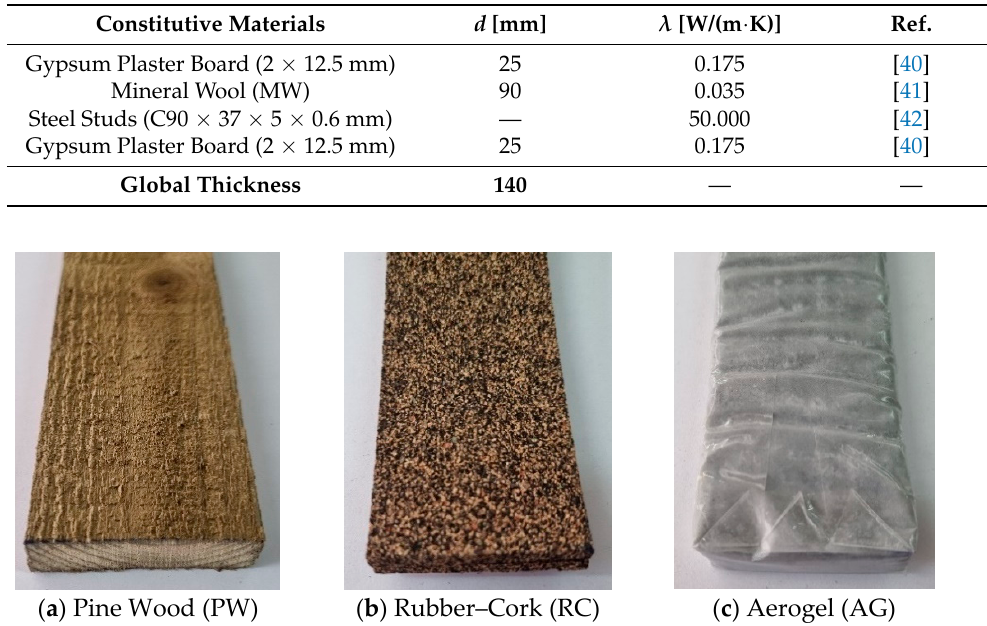
Figure 2. Thermal break strip materials assembled on the LSF partitions. Table 2. Thermal conductivities ( λ ) of the thermal break